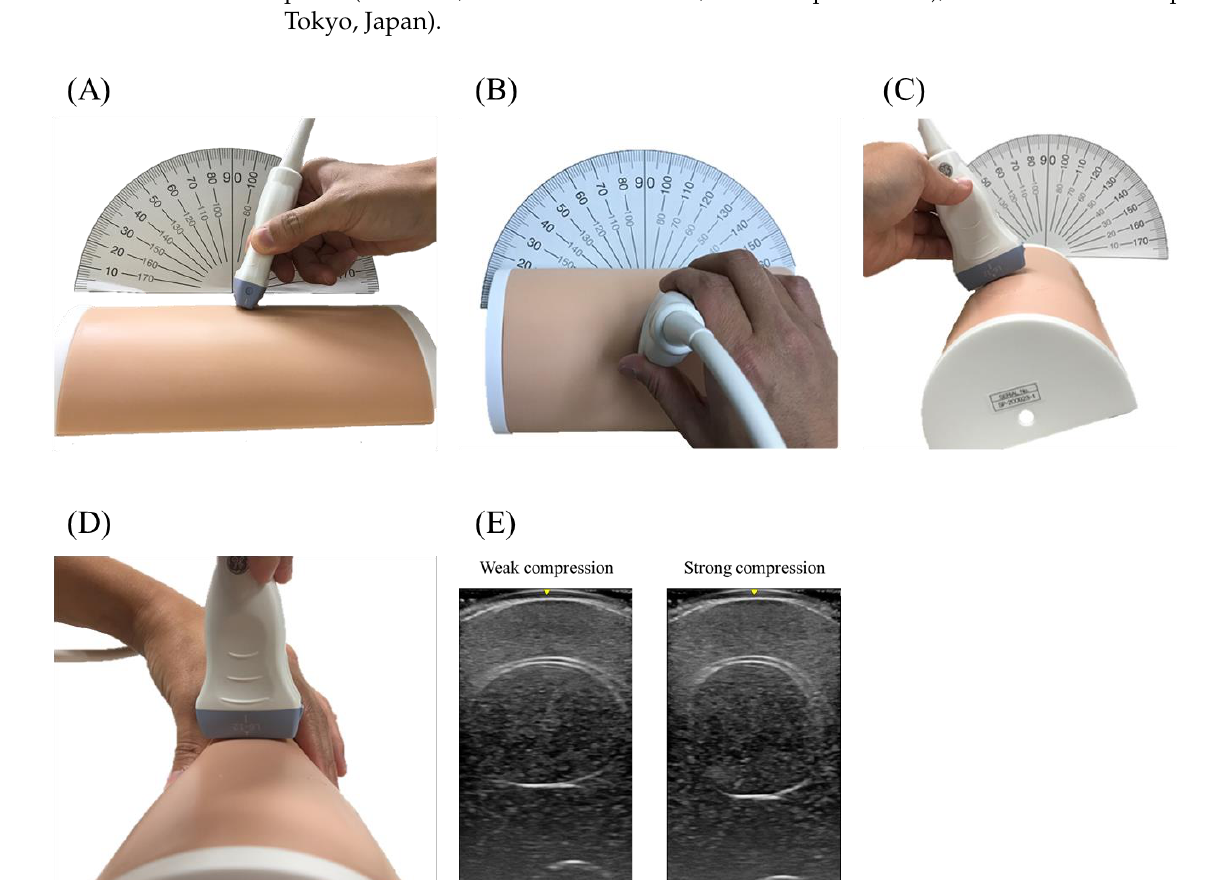
Figure 2. Measurements in various conditions (Study 1). The measurements were conducted in various conditions. ( A ) pennation angle change. ( B ) Horizontal angle change. ( C ) Rotation of phantom. ( D ) Compression from the side. ( E ) Ultrasound scanning image at weak or strong compression.